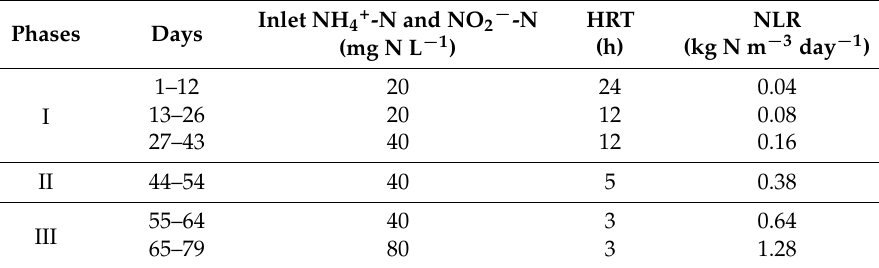
Table 2. Phases of experimental